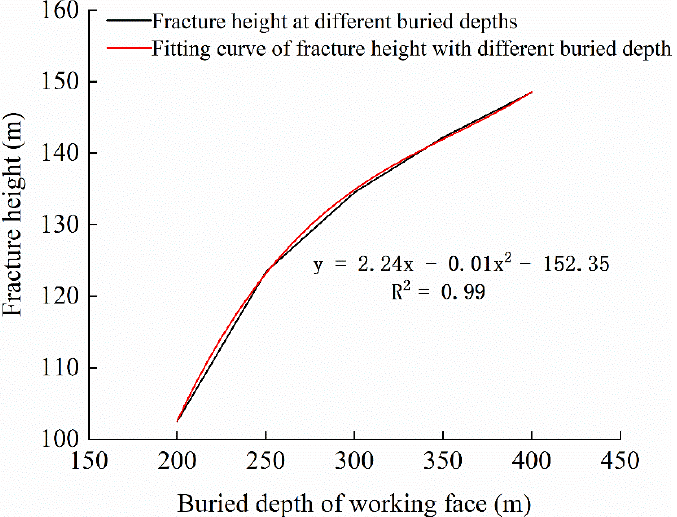
Figure 13. The fit curve of the development height of overlying strata fractures under different buried depth conditions.